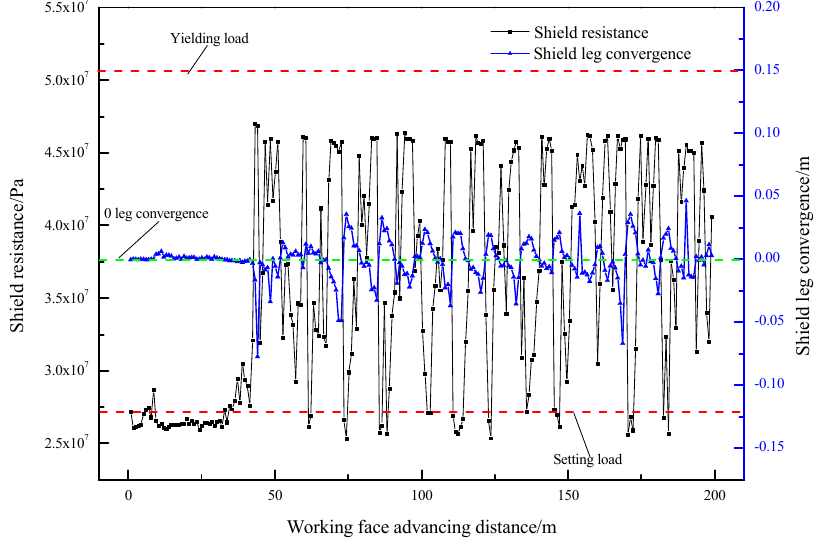
Figure 6. Changes of shield resistance and leg convergence under 3.5 m mining height.